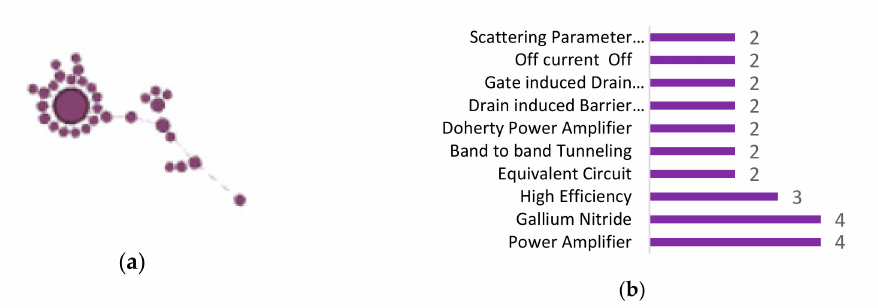
Figure 22. Representation of the New Transistors community: ( a ) Isolated distribution of publications. ( b ) Keywords of the